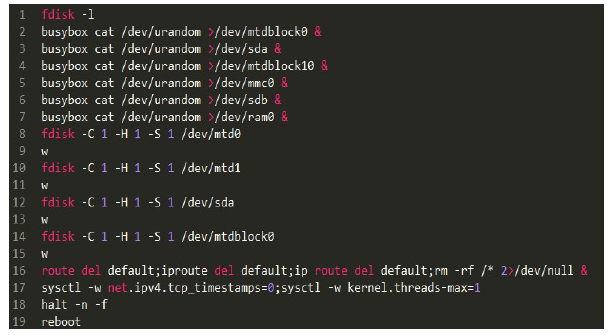
Figure 3. BrickerBot Command